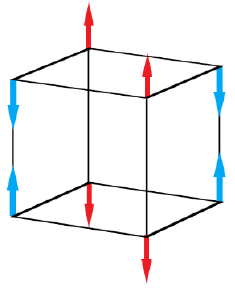
Figure 3. G – type magnetization order.